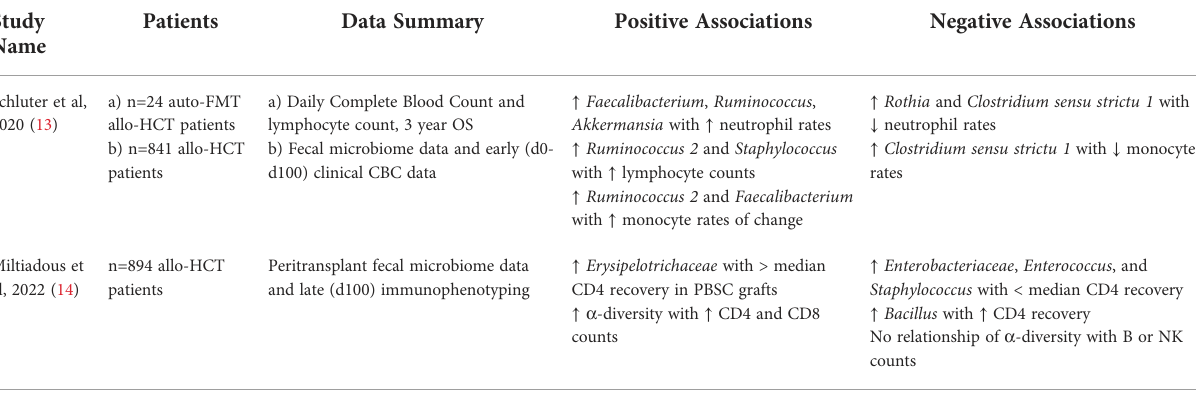
TABLE 2 Clinical Associations between Intestinal Microbiota and Immune